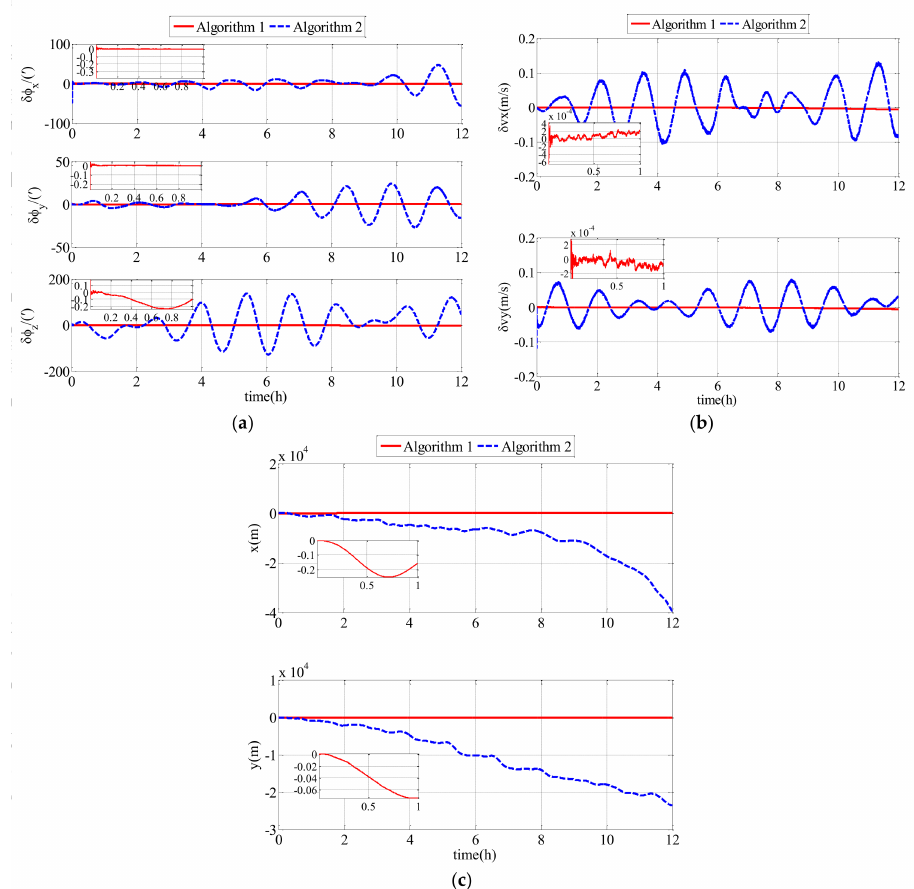
Figure 9. Estimation errors based on Algorithm 1 and Algorithm 2 in the simulation: ( a ) attitude estimation errors; ( b ) velocity estimation errors; ( c ) position estimation errors.